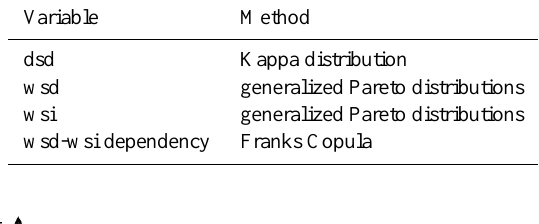
Fig. 1. 90% bootstrap confidence band of simulated flood values (resampled 1000 times) using different sample sizes.